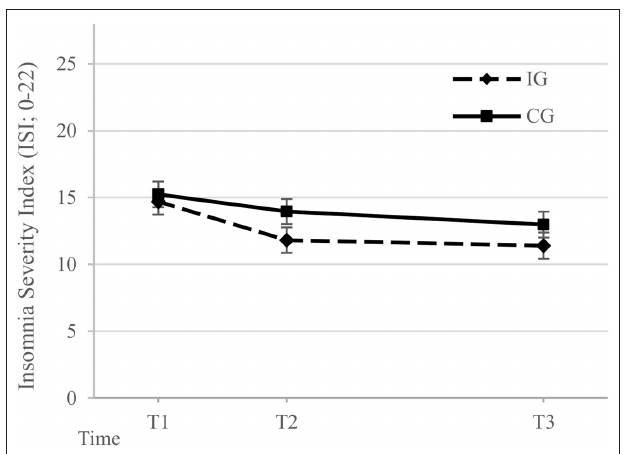
FIGURE 2 | Model-based estimates of the Insomnia Severity Index scores (82) in the intervention group (IG) and control group (CG) at Baseline (T1), 1-month follow-up assessment (T2), and 3-months follow-up assessment (T3). The model includes the factors time, group, and their interaction. The error bars represent the estimated standard error of the